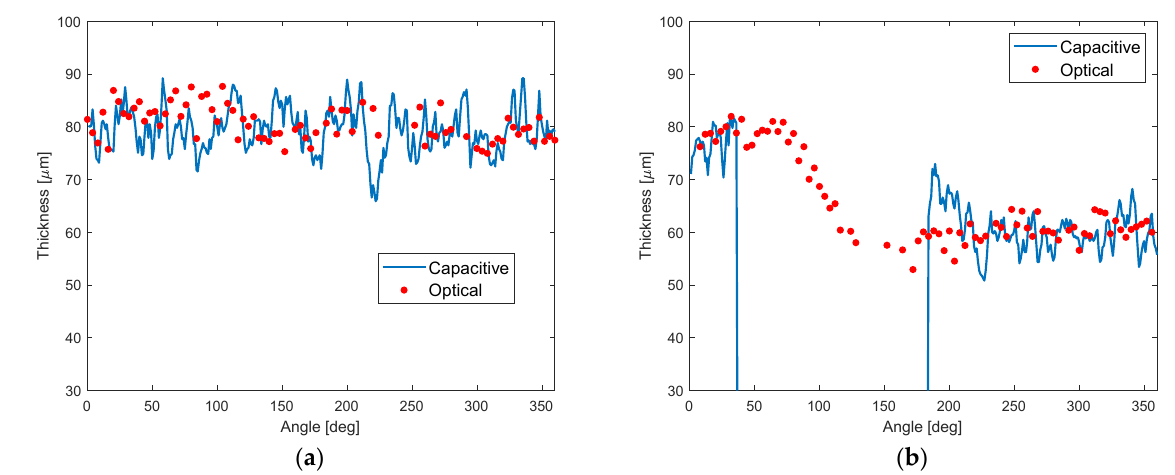
Figure 16. Measured thickness during rotation around the bubble. Comparison of capacitive and optical measurements: ( a ) Constant thickness; ( b ) Measurement during a change of film thickness, from 80 μ m to 60 μ m.